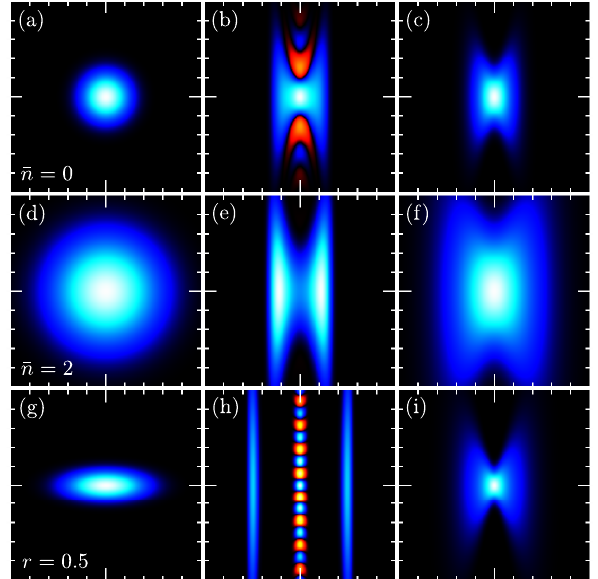
FIG. 2. Mechanical Wigner functions of initial states (left), conditional states (center), and unconditional states (right). is the horizontal axis, P is the vertical axis. The plot ( X M M range is (cid:5) 5 for all axes. Color scale: black is for zero magnitude, blue for positive values, and red for negative values.) The initial states are the ground state, (cid:4) n ¼ 0 (a), a thermal state with (cid:4) n ¼ 2 (d), and a momentum-squeezed vacuum state with squeez- ing parameter r ¼ 0 : 5 (g). Conditional states prepared with (cid:2) X ¼ 1 , (cid:1) Q ¼ acting on the corresponding initial states with (cid:3) X X ¼ 6 : 4 has been 1 : 5 , w ¼ 0 : 8 are shown in (b) and (e) and (cid:1) Q X used in (h). The probabilities of obtaining an outcome in the windows used above are: (b) 14.9%, (e) 14.5%, and (h) 1.1%. Note the disappearance of negativity—a quantum-to-classical transition—for initial thermal occupation (e) and if the measure- ment outcomes are ignored (c), (f),